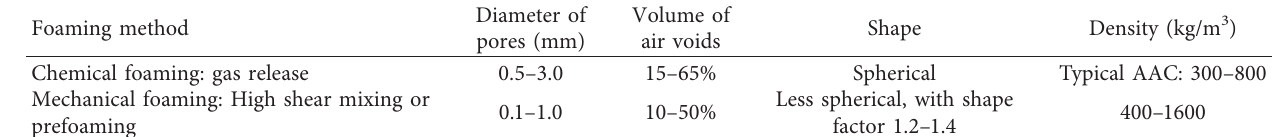
Table 5: Pore features achieved by different foaming methods [26].